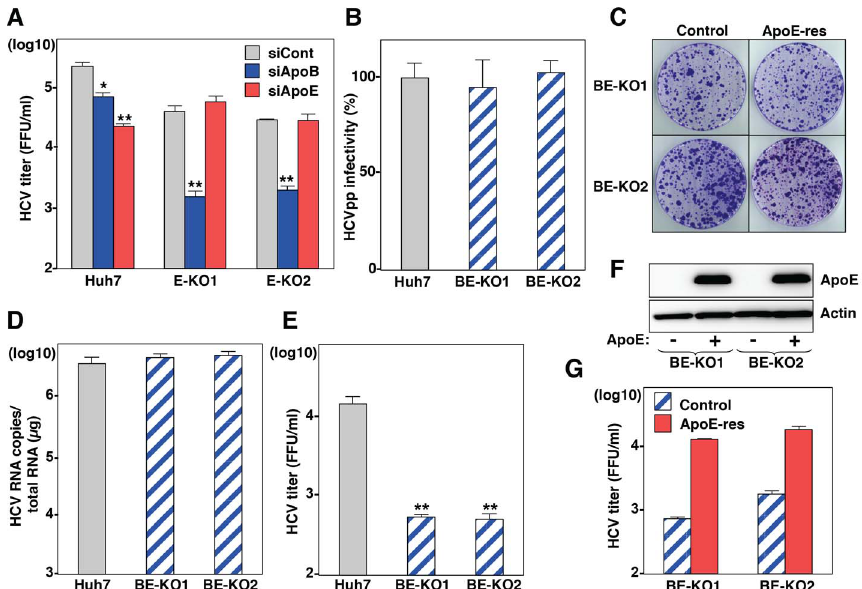
Figure 2. ApoB and ApoE redundantly participate in the formation of infectious HCV particles. (A) Huh7 and E-KO1 cells were infected with HCVcc at an MOI of 1 at 6 h post-transfection with siRNAs targeting ApoB or ApoE, and infectious titers in the culture supernatants were determined by focus-forming assay at 72 h post-infection. (B) HCVpp were inoculated into Huh7, BE-KO1 and BE-KO2 cells, and luciferase activities were determined at 48 h post-infection. (C) A subgenomic HCV RNA replicon of the JFH1 strain was electroporated into BE-KO1 and BE-KO2 cells with/without expression of ApoE by lentiviral vector (ApoE-res), and the colonies were stained with crystal violet at 31 days post-electroporation after selection with 400 m g/ml of G418. Huh7, BE-KO1 and BE-KO2 cells were infected with HCVcc at an MOI of 1, and intracellular HCV RNA (D) and infectious titers in the supernatants (E) were determined at 72 h post-infection by qRT-PCR and focus-forming assay, respectively. (F) Exogenous expression of ApoE in BE-KO1 and BE-KO2 cells by lentiviral vector was determined by immunoblotting analysis. (G) Infectious titers in the culture supernatants of BE-KO1 (gray bars) and ApoE-res cells (red bars) infected with HCVcc at an MOI of 1 were determined at 72 h post-infection by focus- forming